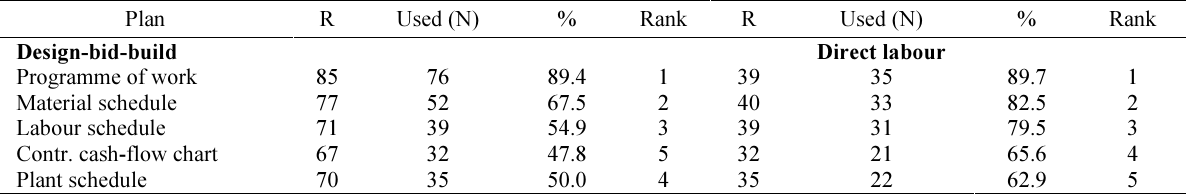
Table 6. Ranking of the levels of use of selected construction stage plans in DBB and DB projects Plan Design-bid-build Programme of work Material schedule Labour schedule Contr. cash-flow chart Plant